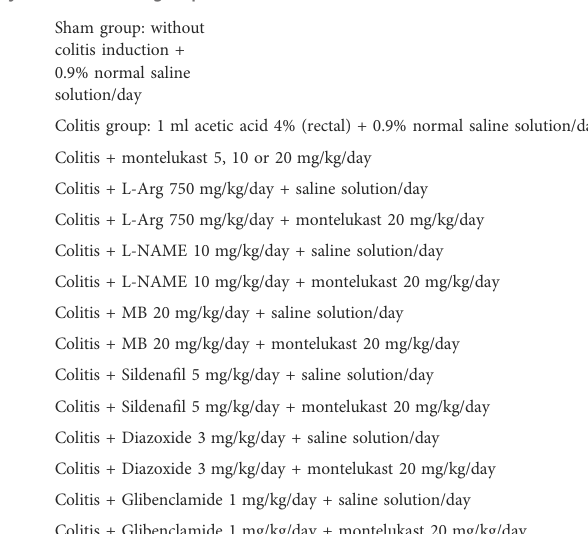
colitis induction